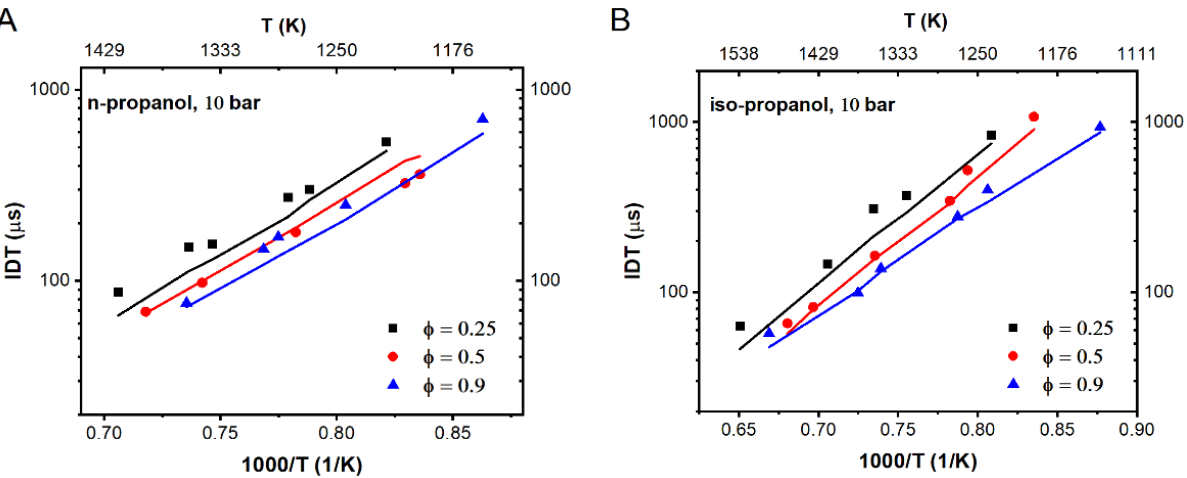
Figure 8. IDTs of ( A ) n-propanol, and ( B ) iso-propanol measured in the HPST at 10 bar and φ = 0.25, 0.5 and 0.9. (Symbols: experimental points; Lines: model predictions).